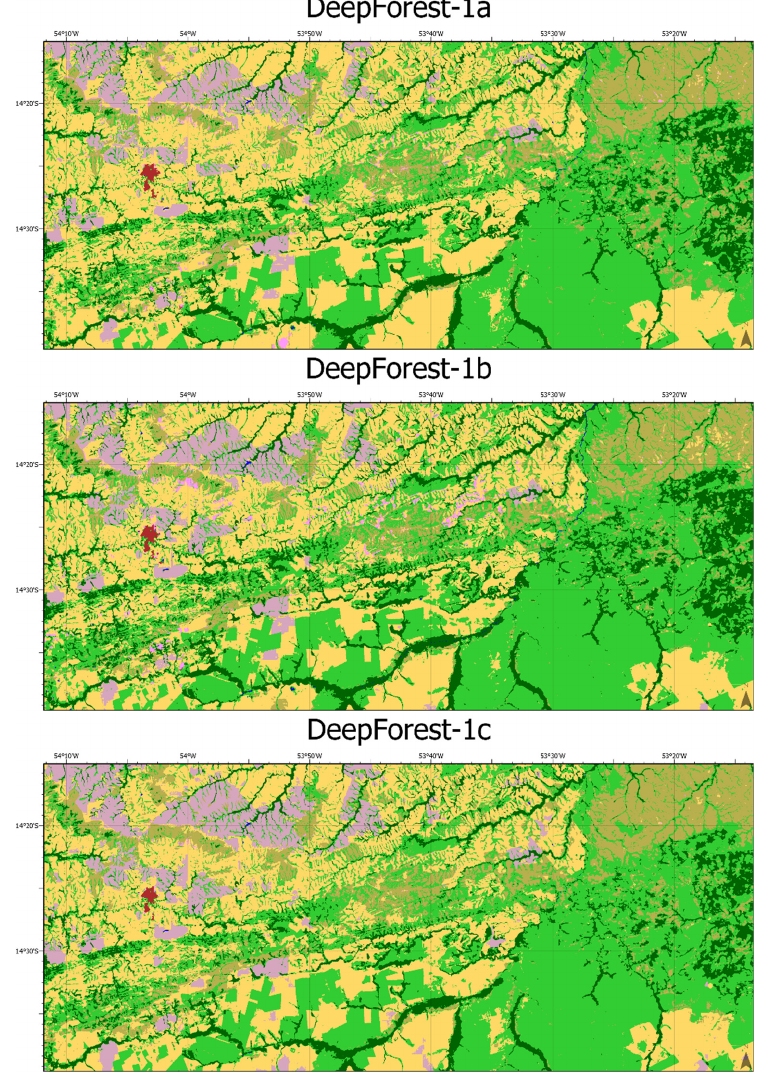
Figure 9. Classification maps produced with the presented early fusion models DeepForest ‐ 1a/b/c. The legend for these maps is presented in Figure 8. The two representation ‐ fusion models, DeepForest ‐ 2a and ‐ 2b, showed more fi ‐ ne ‐ grained classifications compared to the other models (cf. Figure 10). As in the Map ‐ Biomas label map, these models produced less homogenous large patches. None of the tiling artifacts from the other models were present here. However, structures such as the river in the northeastern part of the extent were not present in the classification maps of either of these models. They also seemed to omit the other non ‐ vegetated area class completely. The classification of the urban area visible in the maps seemed to be more concise with the labels.